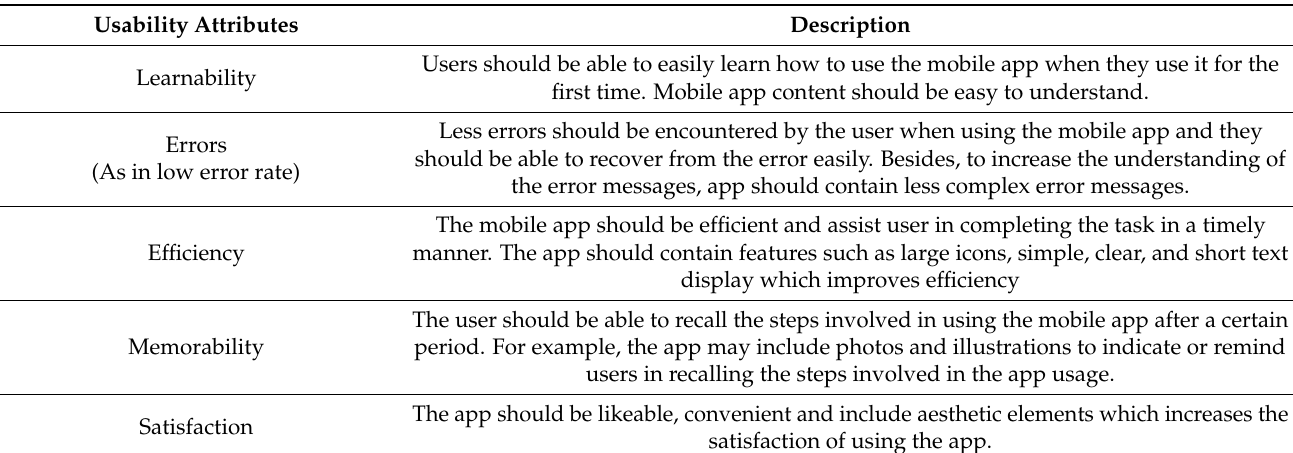
Table 1. The usability